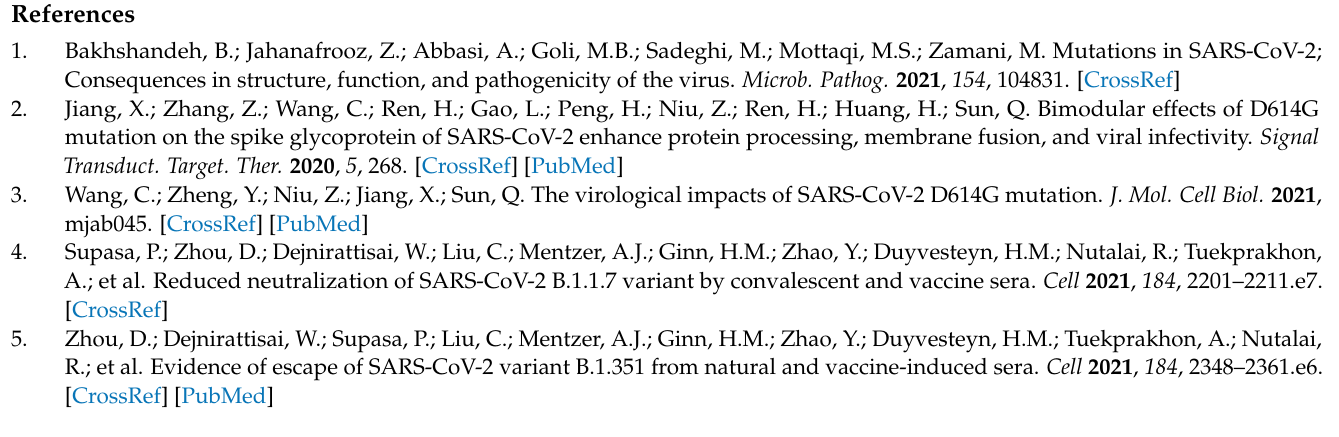
the immune response. Table S1: SARS-like viruses and conserved peptides. Table S2: MHC-I epitopes prediction for the Oriental and Caucasian populations. Table S3: SARS-CoV-2 variants defining mutations. Table S4: CDR3 clone patterns in TCR β repertoires of healthy cohort. TCR β repertoire seq: TCR β repertoire sequencing data of the three groups including ST, RE, HD, with 5 samples for each